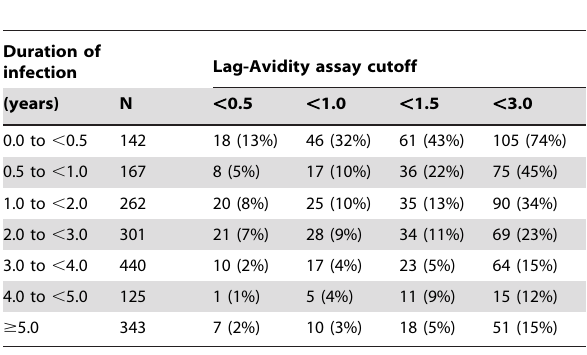
Table 1. Number of samples classified as assay positive using the LAg-Avidity assay alone.